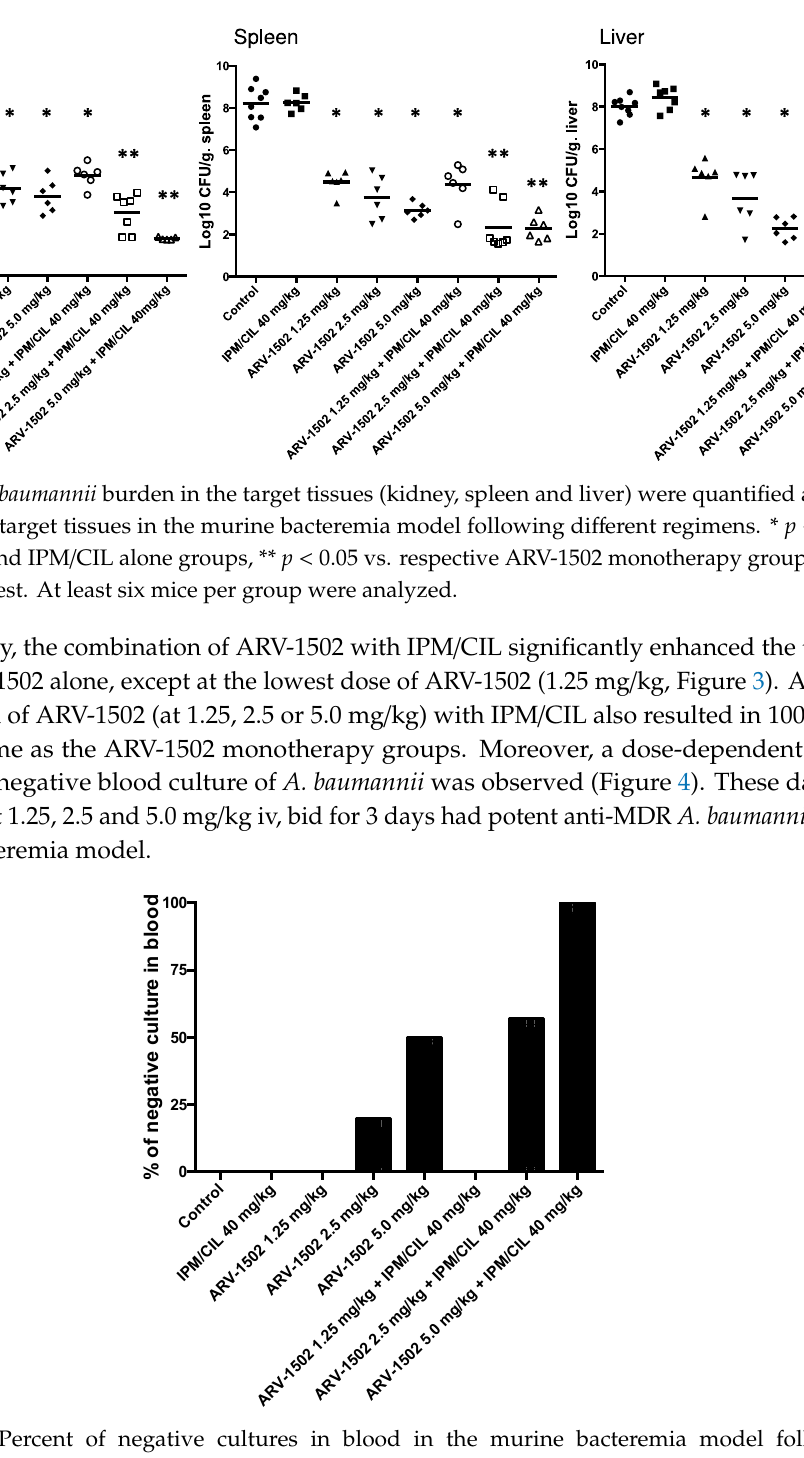
Figure 4. Percent of negative cultures in blood in the murine bacteremia model following di ff erent regimens.